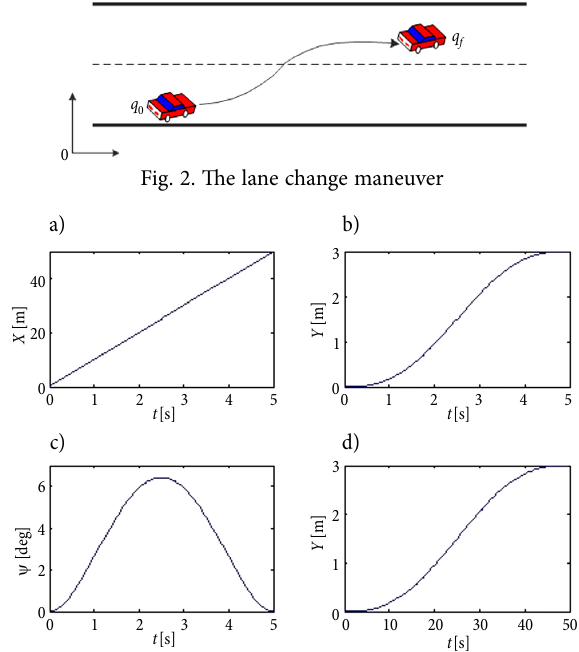
Fig. 3. The planned path for lane change